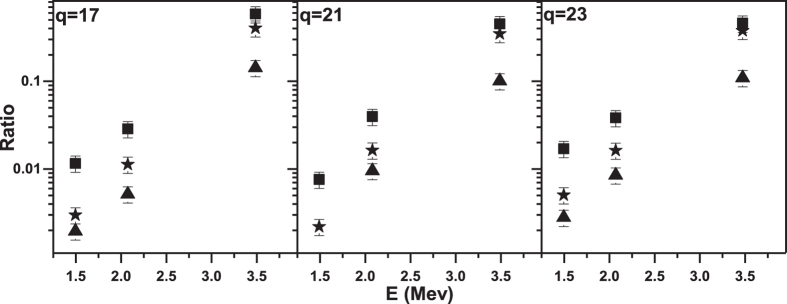
Variations in the ratios σLα/σMO, σLβ1/σMO, σLβ2/σMO as functions of the incident energy for charge states of 17, 21 and 23.Square: σLα/σMO; Star: σLβ1/σMO; Triangle: σLβ2/σMO.